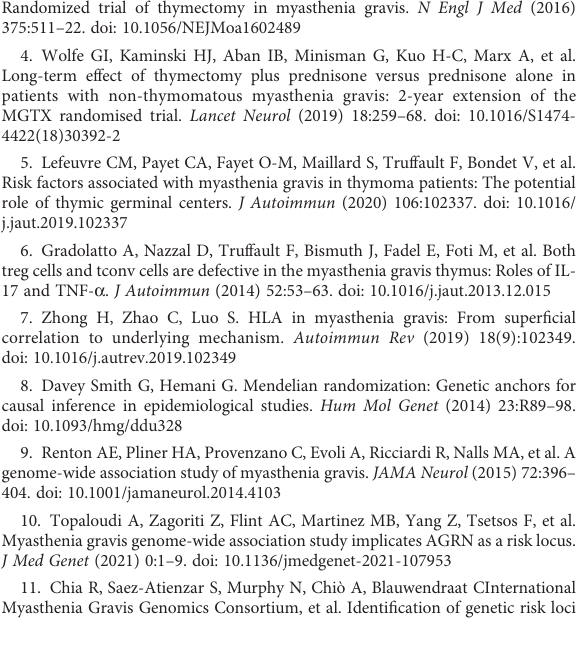
SUPPLEMENTARY FILE 1 The detailed instrumental SNPs information of primary and secondary analysis.